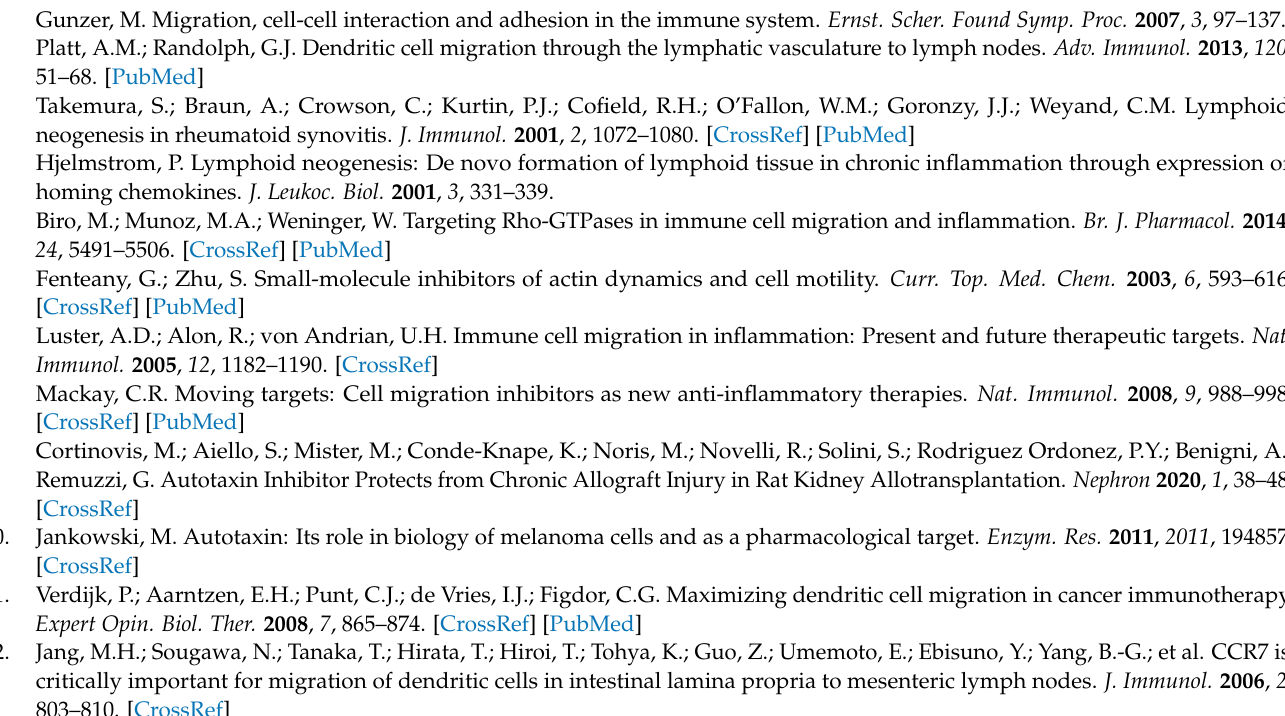
Table S2: The counting results of the migration assay in Figure S1D. Table S3: The counting results of the migration assay in Figure 2H. Table S4: The counting results of the migration assay in Figure 3F. Video S1: Homing ability of rmEnpp2-treated DCs in LNs. Video S2: Homing ability of non-treated DCs in